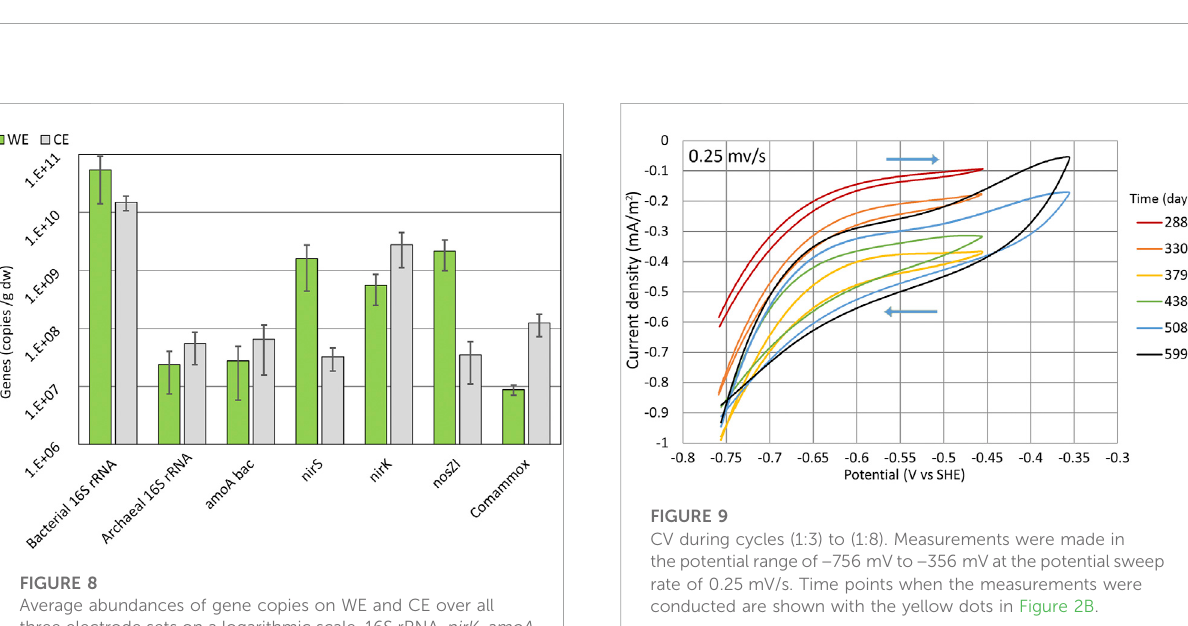
CV during cycles (1:3) to (1:8). Measurements were made in the potential range of − 756 mV to − 356 mV at the potential sweep rate of 0.25 mV/s. Time points when the measurements were conducted are shown with the yellow dots in Figure